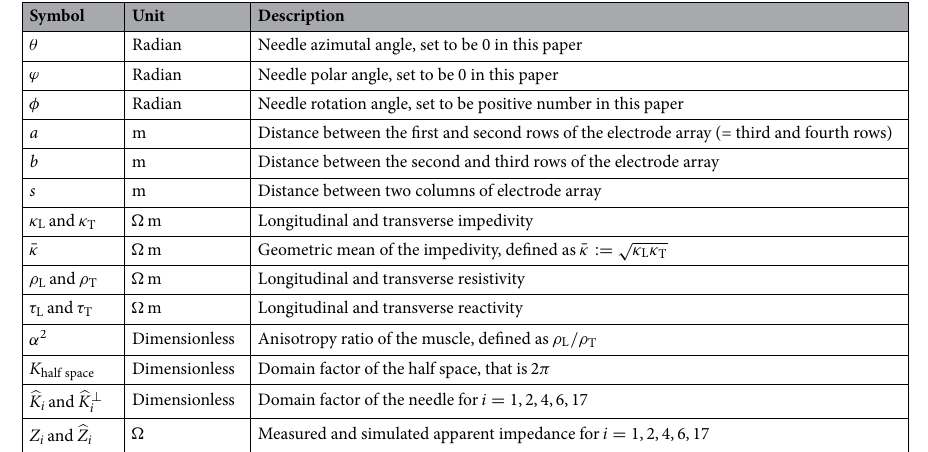
Table 1. Symbols and parameters used in this